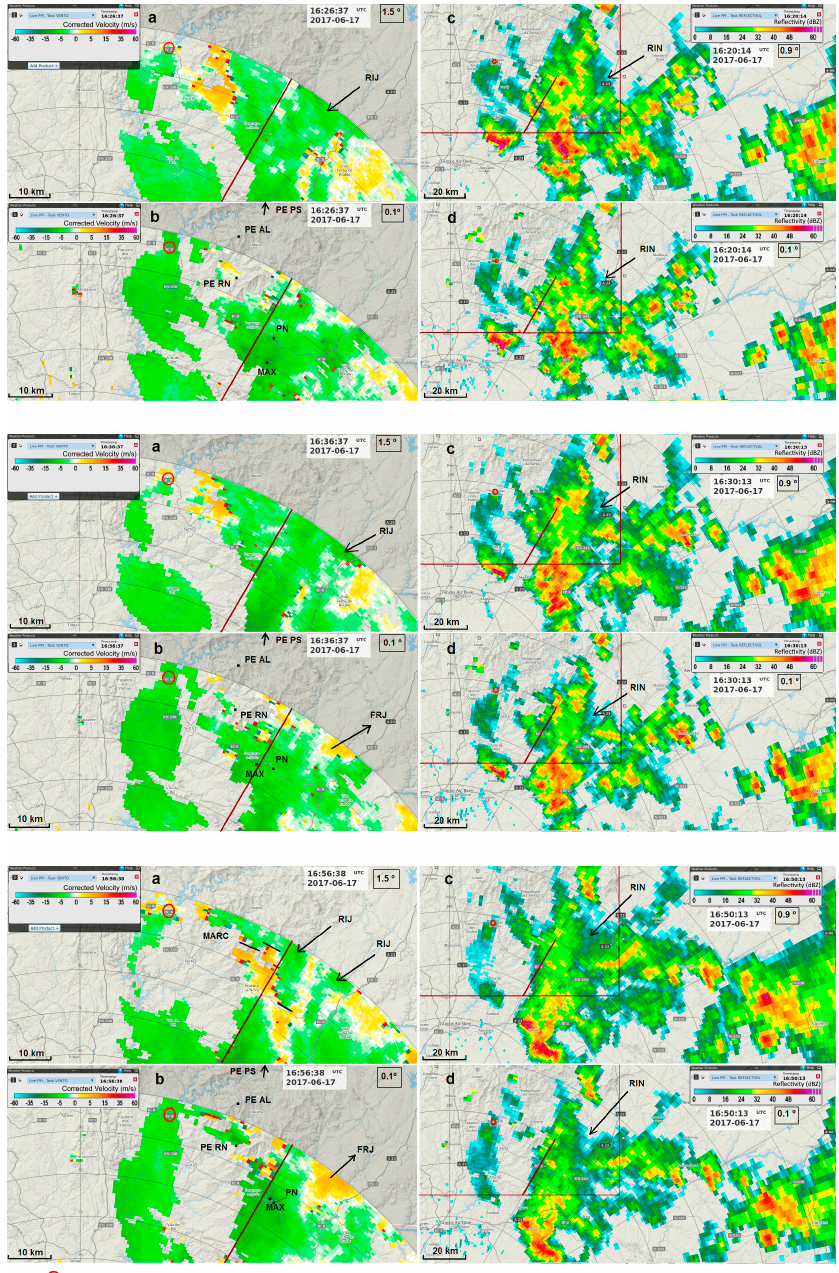
Figure 11. PPI of storm-relative velocity, 1.5 ◦ tilt ( a , e , i ), 0.1 ◦ tilt ( c , g , k ); PPI of reflectivity, 0.9 ◦ 2 tilt ( b , f , j ), 0.1 ◦ tilt ( d , h , l ). Lines in ( b , d , f , h , j , l ) delimit the insertion of the observed area in ( a , c , e , g , i , k ) respectively. 17th June 2017, C/CL radar. Top panel: 16:26 UTC ( a , c ); 16:20 UTC ( b , d ). Middle panel: 16:36 UTC ( e , g ); 16:30 UTC ( f , h ). Bottom panel: 16:56 UTC ( i , k ); 16:50 UTC ( j , l ).PE AL, PE RN represent Alvelos and Rendeiros Windmill Parks (PE PS Pampilhosa Park is outside the